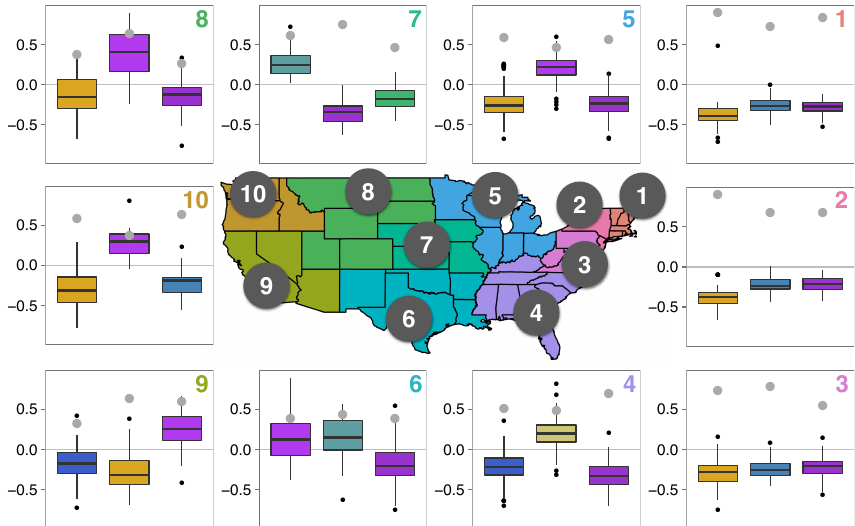
Normalized 95th Quantile Regression Coefficients for Most Frequent by Region